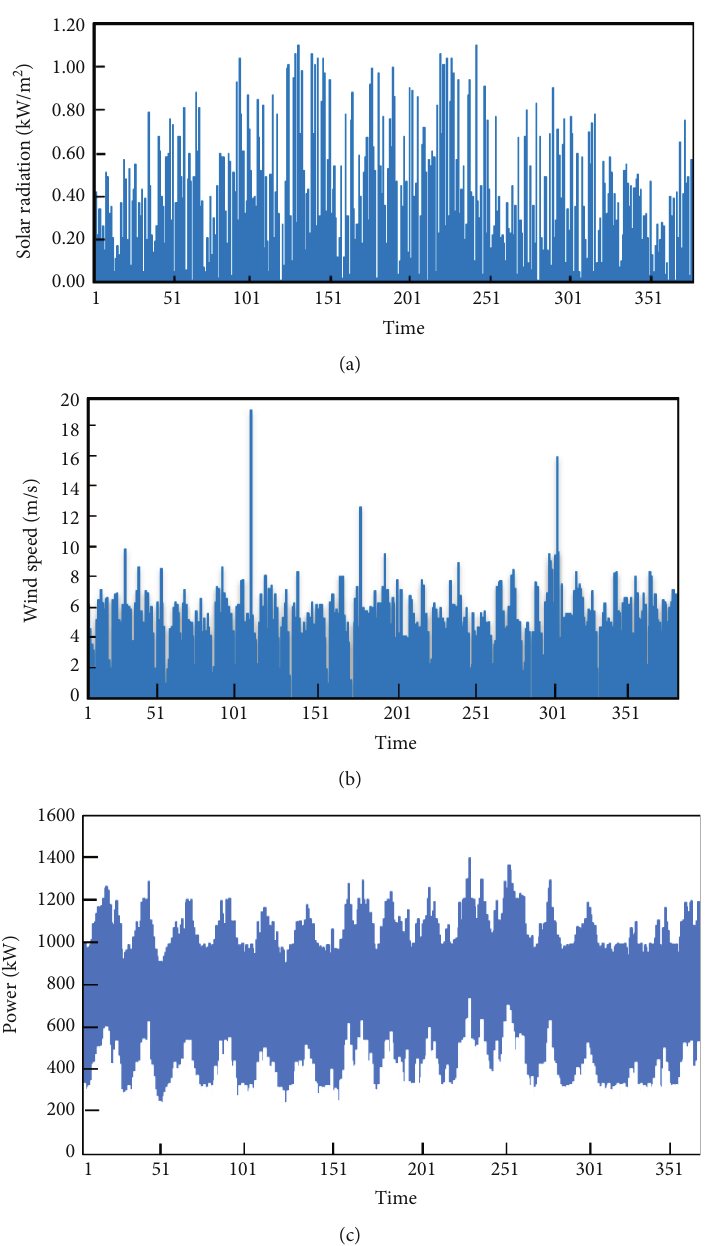
Figure 12: Environmental data and residential load curve. (a) Solar radiation curve. (b) Wind speed curve. (c) Residential load